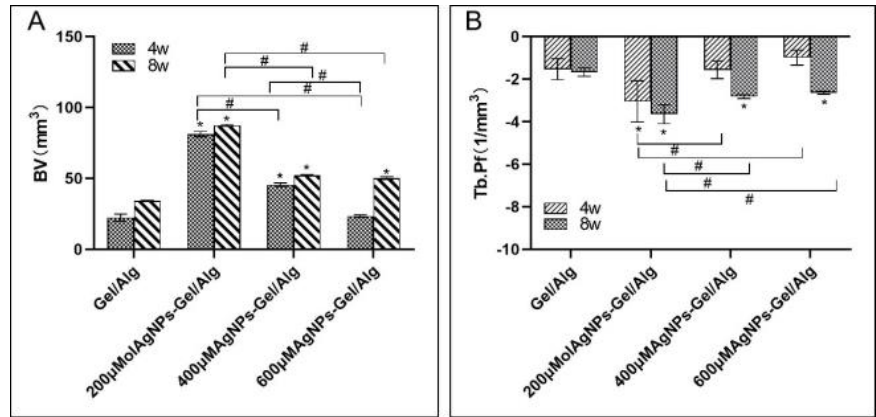
Figure 8. ( A ) New bone volume (BV) and ( B ) trabecular bone connectivity (Tb.Pf) in different groups at 4 and 8 weeks after operation. * p < 0.05 vs. control group; # p < 0.05 the difference between AgNP– Gel/Alg groups.